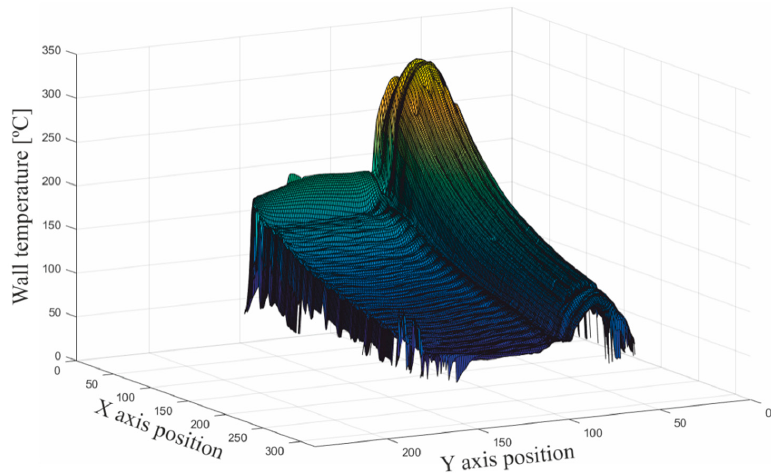
Figure 6. Three-dimensional (3D) graph of the temperatures identified as belonging to the boiler at this step of the procedure.